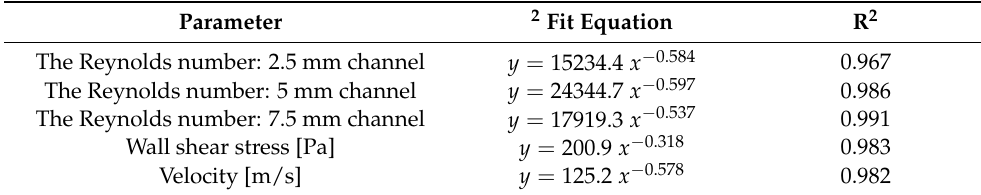
Figure 11. Cleaning times plotted against the wall shear stress. Table 2 shows the correlation of cleaning time obtained for all the flow parameters. Table 2. Parameters and correlation